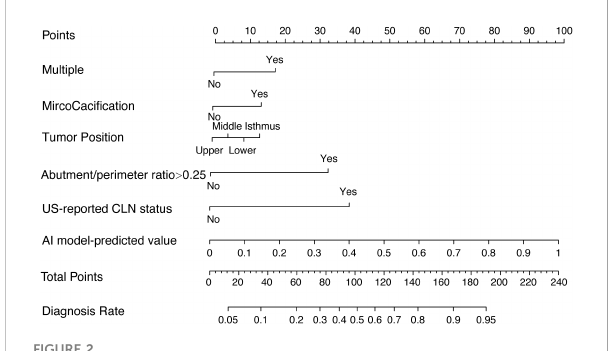
FIGURE 2 Thyroid cancer lymph node metastasis nomogram for predicting CLNM in PTC